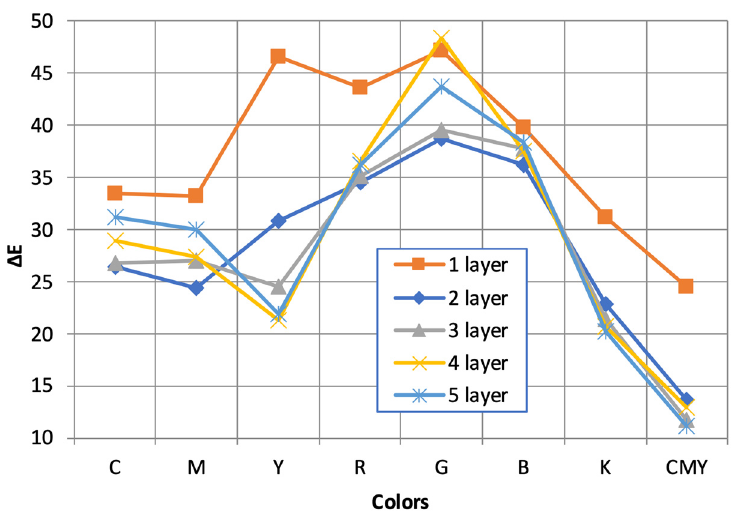
Figure 7. Different colors changes of ∆ E value depending on dye layers when printing in 16 passes.